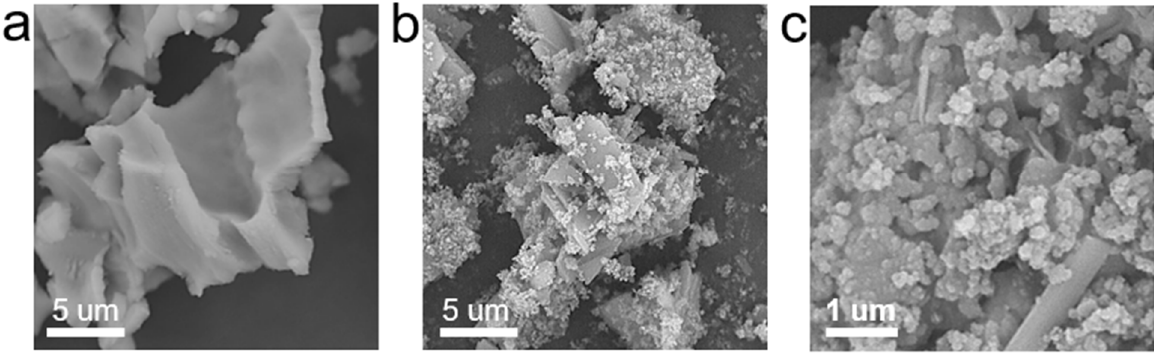
Figure 2. SEM images of SP ( a ), SP@nZVI particles ( b ) and SP@nZVI particles ( c ) at magnifications ×10,000, ×10,000, ×30,000 respectively.